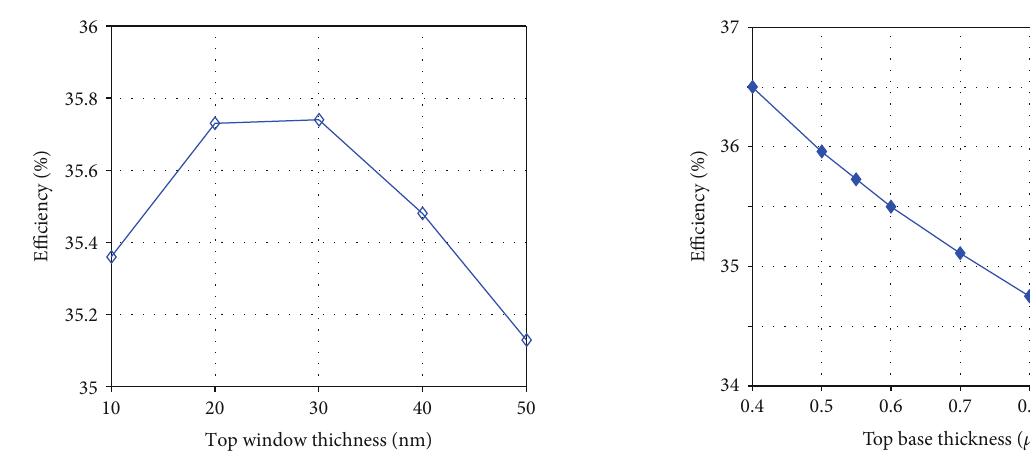
Figure 8: DJ cell e ffi ciency vs. top window layer thickness. Figure 9: DJ cell e ffi ciency vs. top base